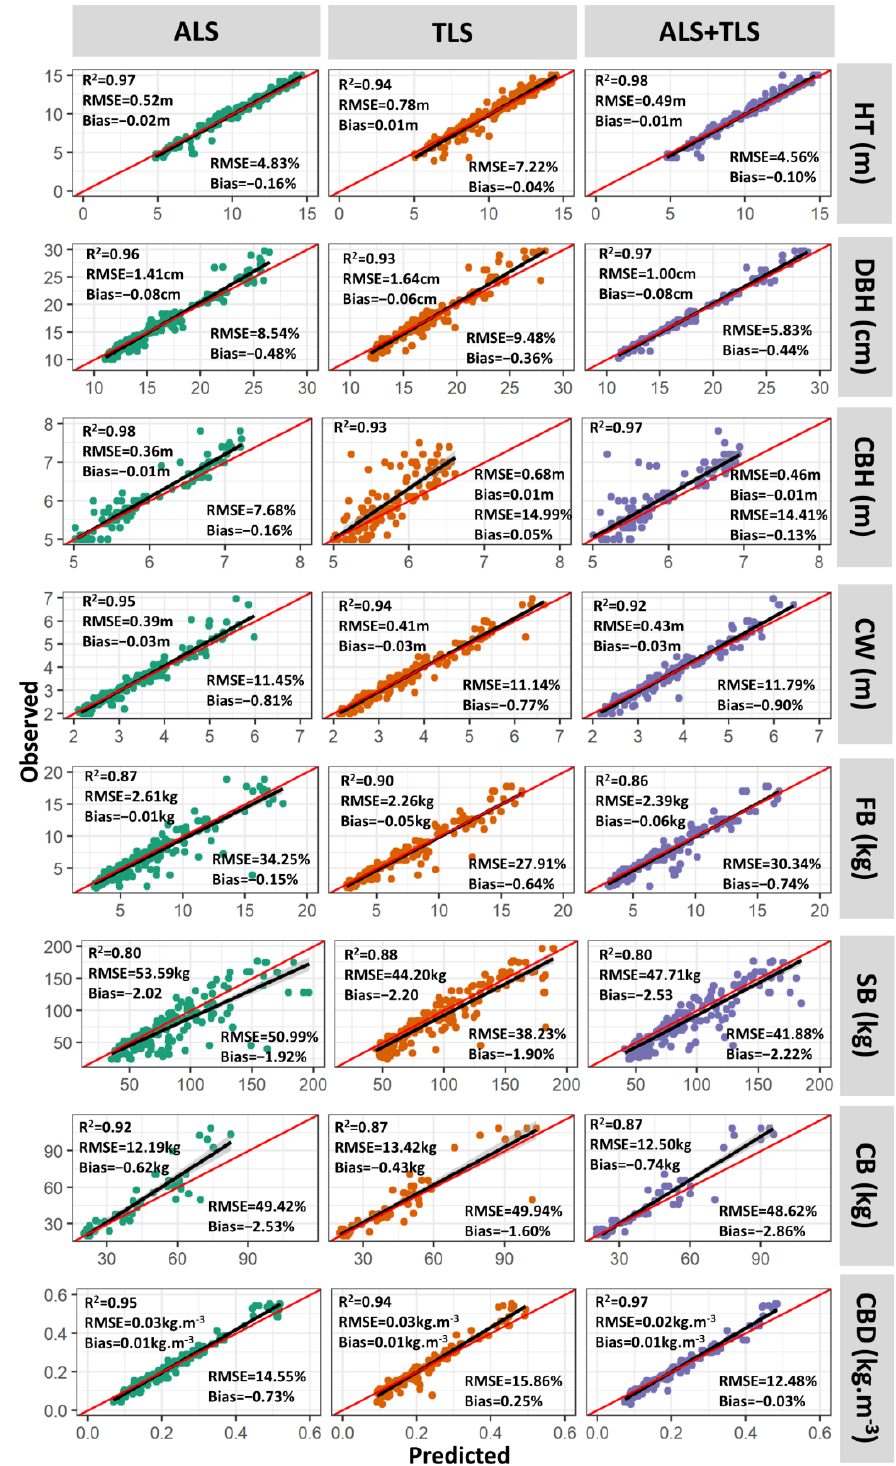
Figure 7. Scatter plots of observed versus predicted crown-level structure and fuel load attributes, RMSE, and bias across tree attributes and lidar datasets. The predicted values are derived from the average of the 500 bootstrap iterations. Diameter at breast height (DBH); tree height (HT); crown width (CW); canopy base height (CBH); foliage biomass (FB); steam branches biomass (SB); crown biomass (CB); crown bulk density (CBD). The diagonal lines represent the perfect match (1:1) between observed and predicted